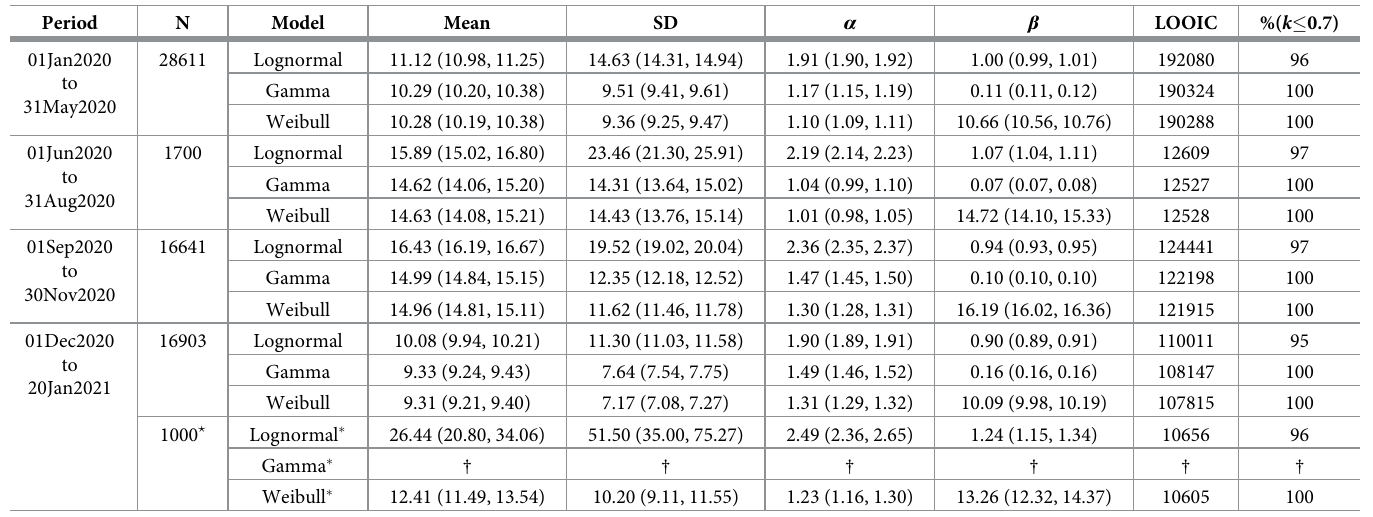
Table 3. Results for the time from hospitalisation to death, segmented by hospitalisation date. Period